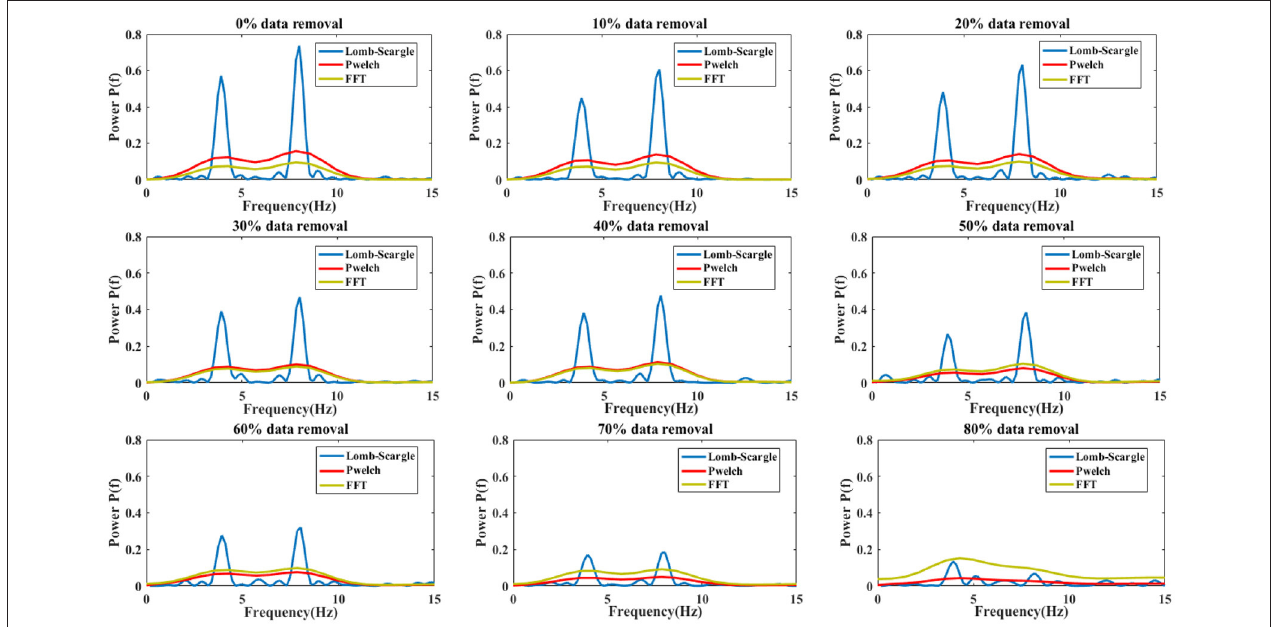
FIGURE 4 | The comparison results of spectral power estimations for the complete signal and incomplete signal with different proportional removal (from 10 to 80% with a step of 10%). Three estimation methods were used: Lomb-Scargle, Welch and FFT periodogram.